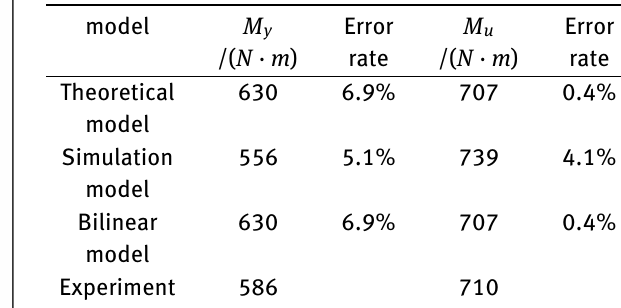
Table 5: Error rate of